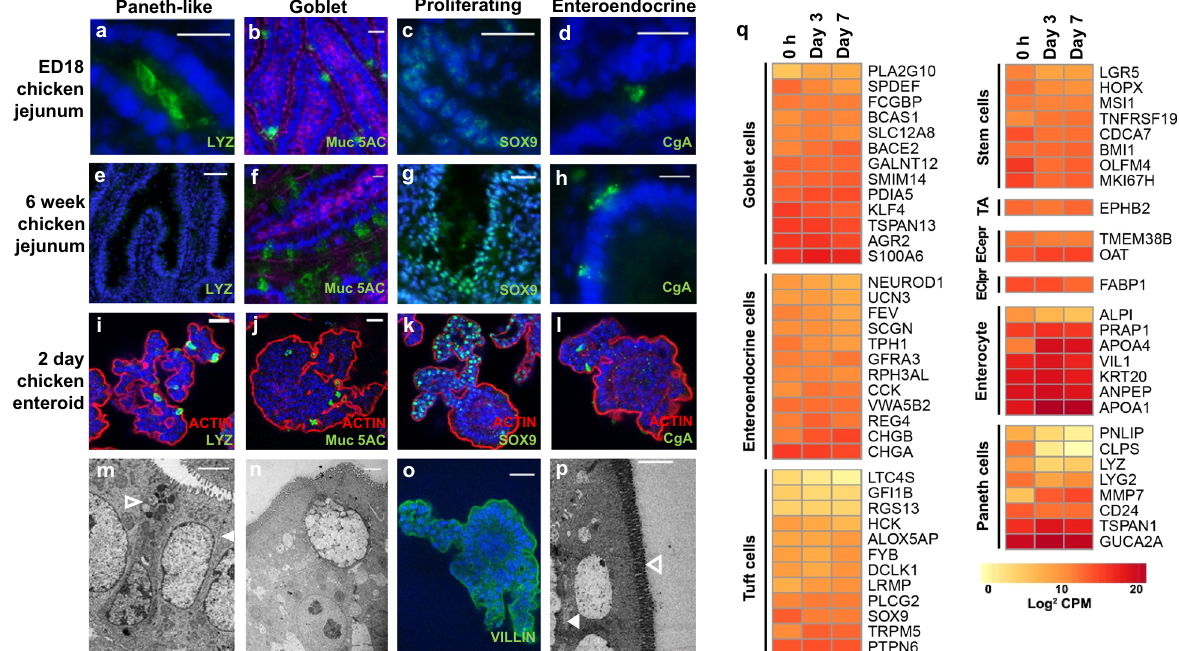
Fig. 3 Multicellular composition of chicken enteroids. Confocal images of a – d embryonic jejunum, e – h 6 week old chicken jejunum, and i – l , o embryonic chicken enteroids at 2 days of culture. All cells are counterstained with DAPI (blue). The cells are stained for a , e , i Lysozyme C (green, Paneth cells), b , f ,